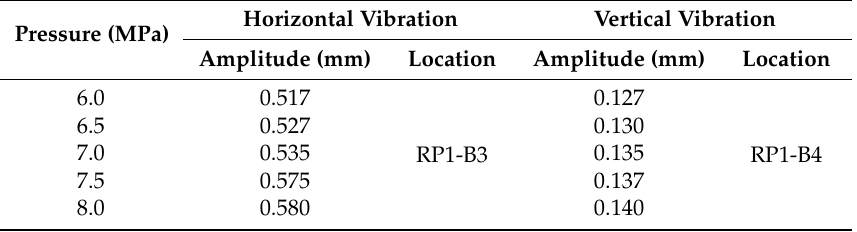
Table 10. The maximum amplitudes of RP1 outlet pipe at different pressures.